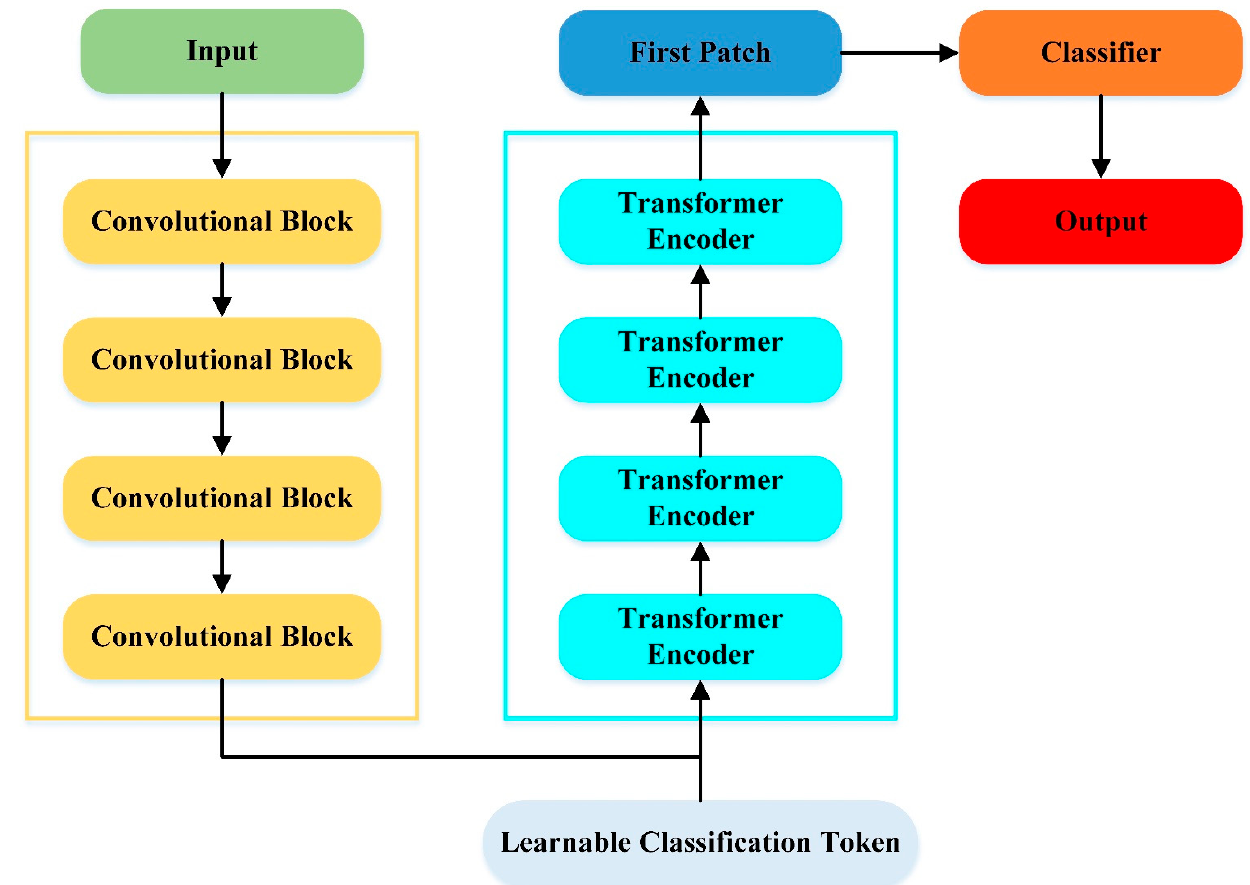
Figure 2. The overall architecture of the proposed CNN&Transformer model.